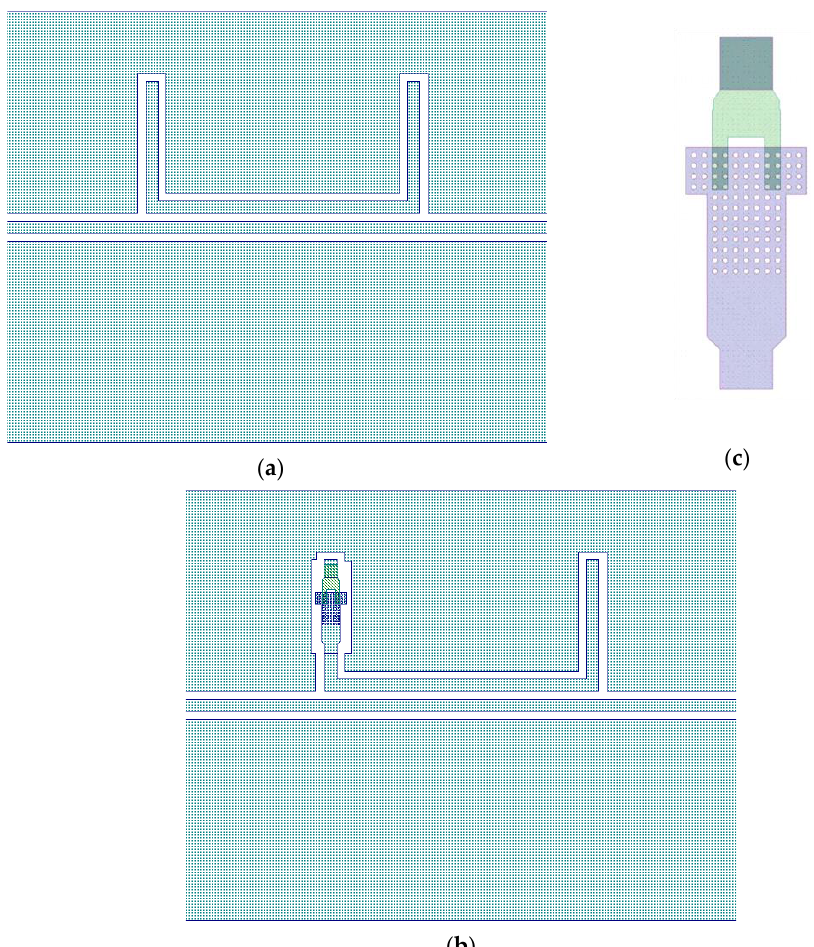
Figure 8. 15 GHz, U-shaped naked resonator ( a ), the resonator loaded by the RF MEMS switch ( b ), and the detailed view of the cantilever switch ( c ).